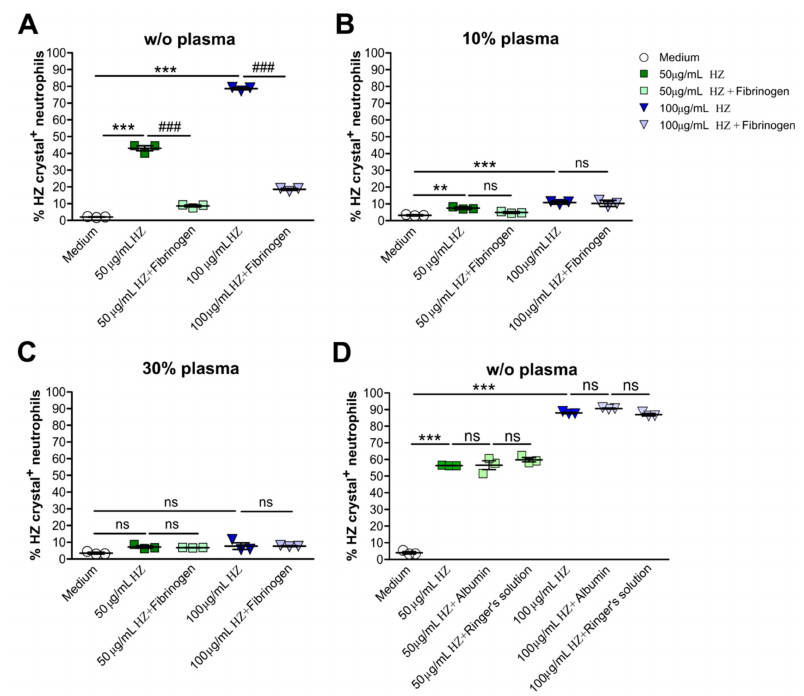
Figure 4. Fibrinogen impaired uptake of hemozoin by human neutrophils. Human neutrophils from healthy volunteers were cultured in the presence or absence of HZ (50 and 100 µ g / mL) and / or with human plasma and / or fibrinogen for 2 h. ( A – C ) The percentage of HZ crystal + neutrophils incubated in the absence or presence of fibrinogen without (w / o) plasma ( A ) or with 10% ( B ) and 30% ( B ) human plasma determined by flow cytometry ( n = 3 donors). ( D ) Neutrophils were cultured in the presence or absence of HZ with or without albumin or Ringer’s solution in RPMI medium, and the percentage of HZ crystal + neutrophils determined by flow cytometry after 2 h ( n = 3 donors). Data are mean ± SD and representative of two independent experiments. ** p < 0.01; *** p < 0.001; ns, not significant using one-way ANOVA. ### p <